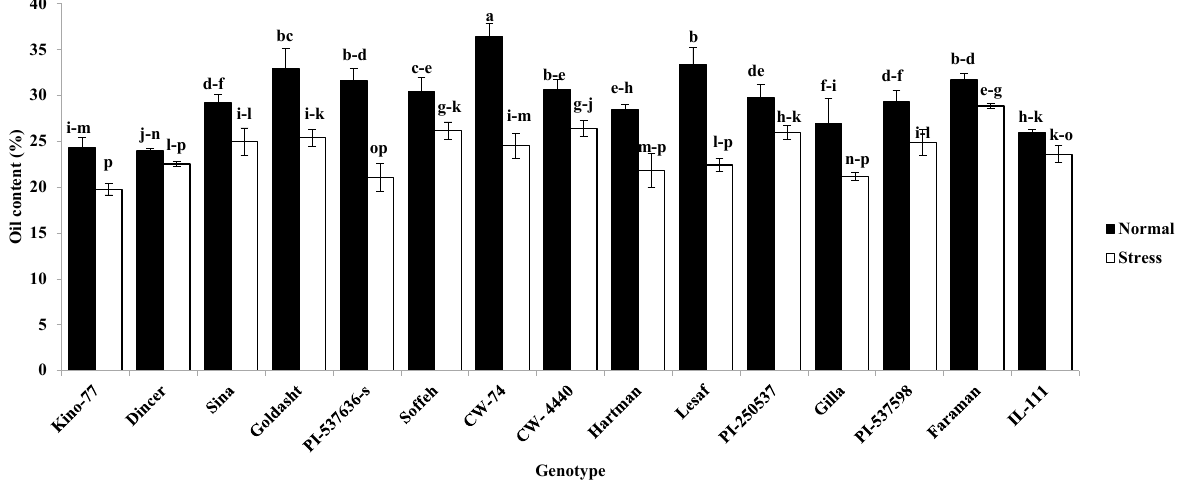
Fig. 7 Interaction effect of irrigation and genotype on oil content. Mean values with the same letters are not significantly different ( p > 0.05) according to the Duncan test. Data are presented as mean ± SEM